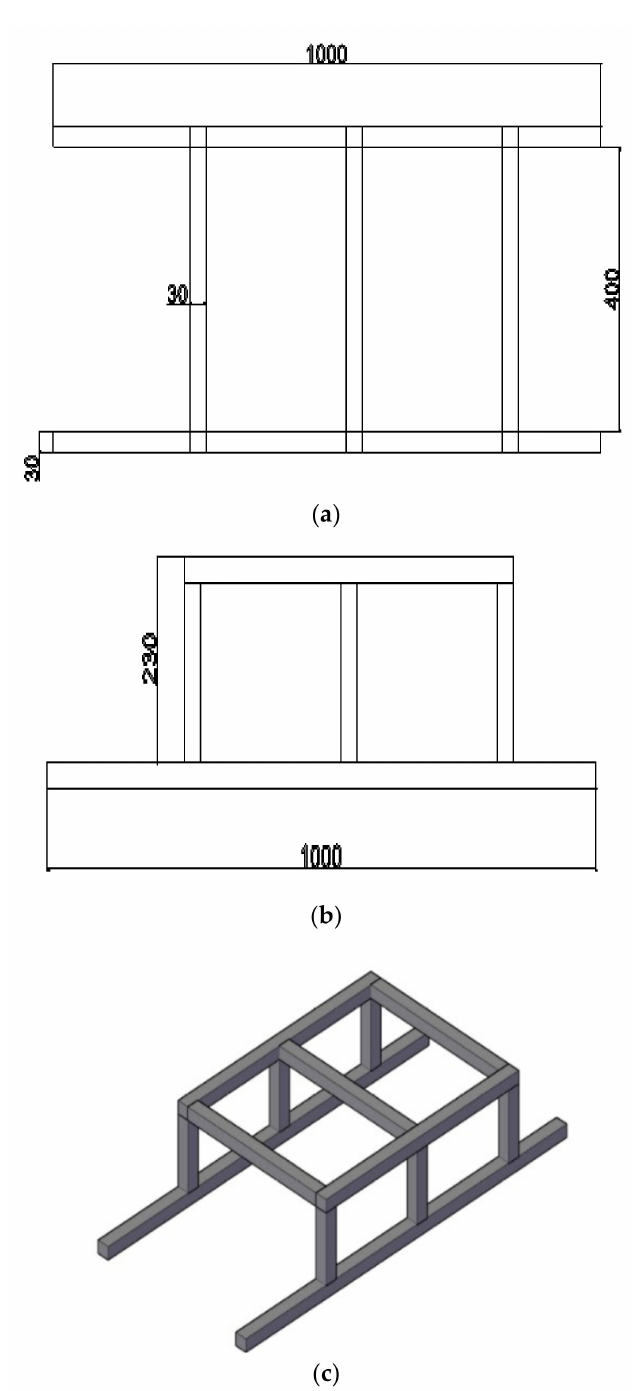
Figure 10. Structural lift frame (dimensions are in mm). ( a ) Plan view. ( b ) Side view. ( c ) 3D view. During the push test, the concrete end slip was measured using a high-precision laser sensor, as shown in Figure 14, to confirm the results obtained from the machine. The dis- placement results obtained from the MTS machine and the laser sensor were agreed